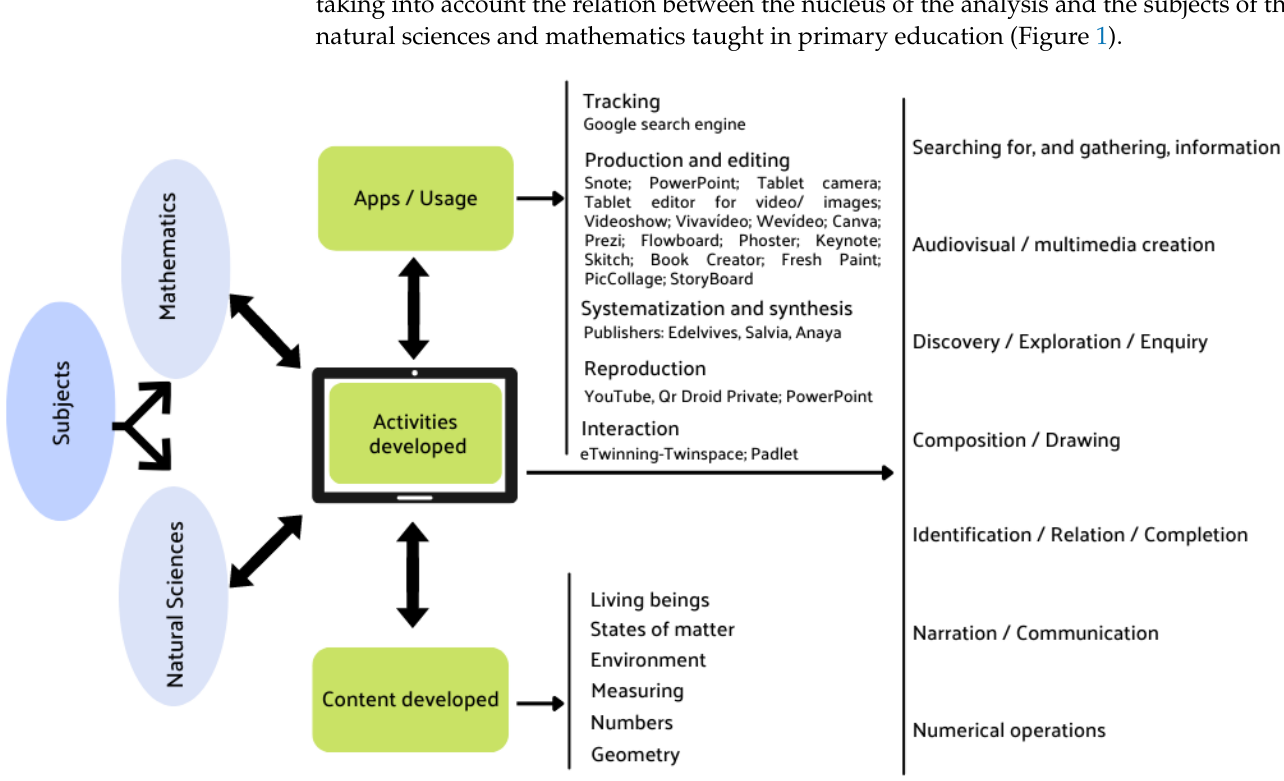
Figure 1. A general view of the categorization obtained.